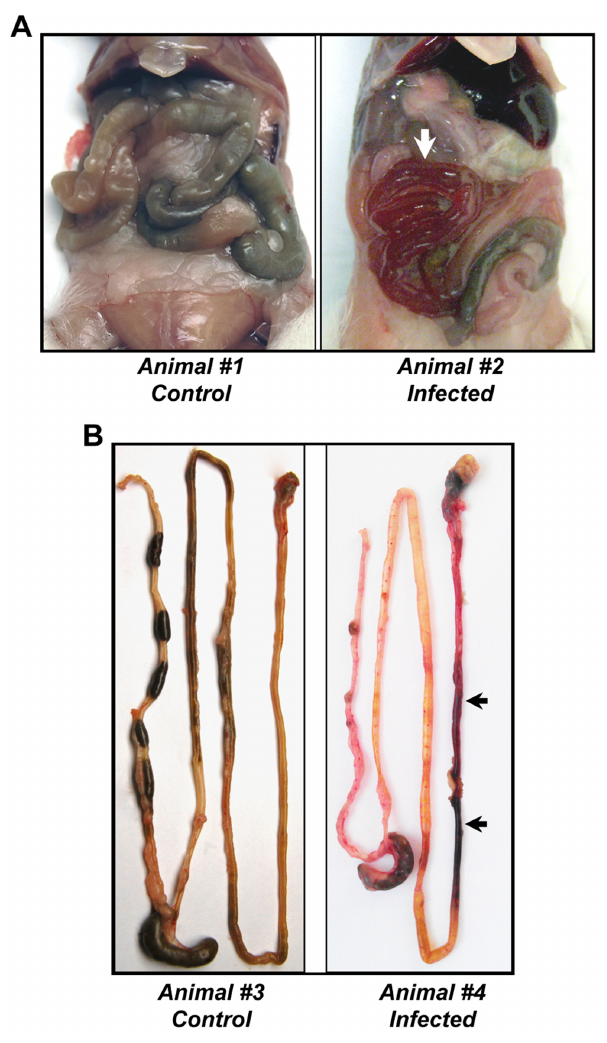
Figure 3. Gastrointestinal anthrax infection in mice is charac- terized by gross hemorrhage. Mice that were treated with intragastric BaS were euthanized when they became moribund, simultaneously with control mice administered the buffer control. Shown are representative gross autopsy findings noted upon exposure of the abdominal cavity ( A ) or following dissection of the gastrointes- tinal tract ( B ). Control animals are shown in the left panels, and BaS infected animals are shown in the right panels. Arrows indicate regions with blood evident within the intestinal lumen.